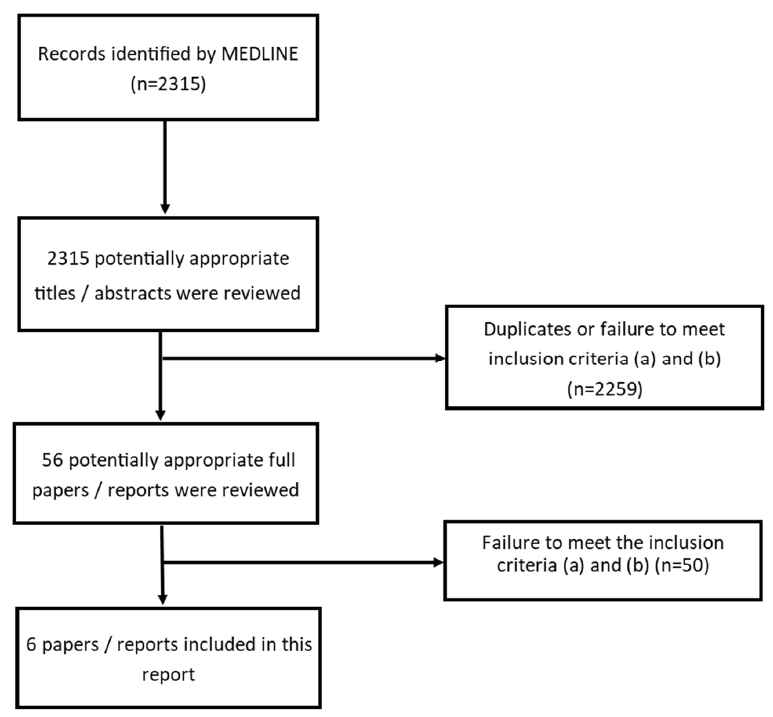
Figure 2. A flow chart illustrating the second literature search process.